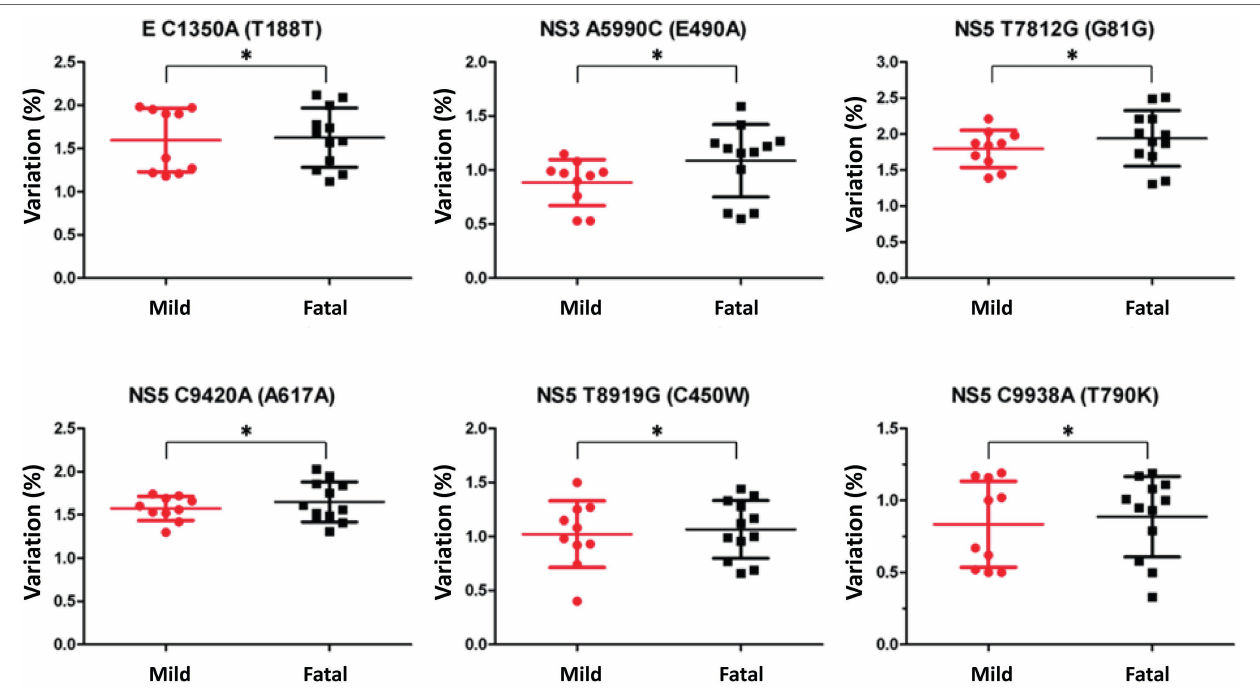
FIGURE 3 | Nucleotide variation comparison in mild and fatal cases. Variation comparison of the selected positions between mild (red) and fatal (black) cases. The variations selected by LoFreq with a p -value <0.05 showed that fatal cases had higher variation percentage compared to mild cases. Statistical difference of variation percentages at each position between mild and fatal cases was calculated using Chi-square analysis * p <